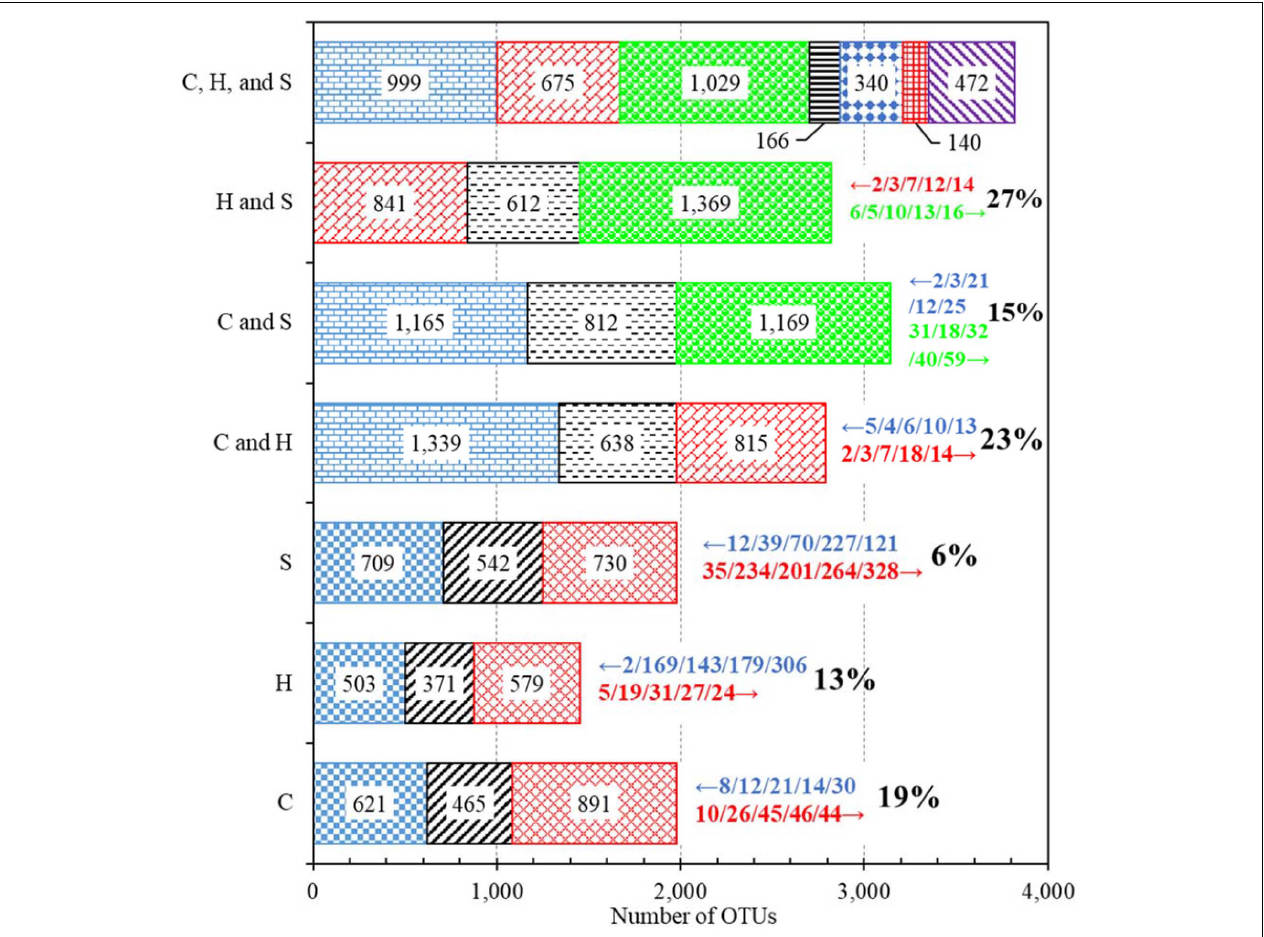
FIGURE 1 | Numbers of OTUs identified from different groups of water samples. C : Cold tap water. H : Hot tap water. S : Shower water. For each of the three horizontal bars of C , H , and S , the left, middle, and right segments represent the numbers of OTUs unique to the first draw, shared by the two draws, and unique to the second draw, respectively. For each of the three bars of C and H , C and S , and H and S , the left, middle, and right segments represent the numbers of OTUs unique to cold (for the bars of C and H and C and S ) or hot (for the bar of H and S ) tap water, shared by the two groups of water samples, and unique to hot tap (for the bar of C and H ) or shower (for the bars of C and S and H and S ) water, respectively. For the bar of C, H, and S , the first, second, third, fourth, fifth, sixth, and seventh (left to right) segments represent the numbers of OTUs unique to cold tap water, unique to hot tap water, unique to shower water, shared by cold and hot tap water (excluding shower water), shared by cold tap and shower water (excluding hot tap water), shared by hot tap and shower water (excluding cold water), and shared by cold tap, hot tap, and shower water, respectively. Numbers within bar segments: Numbers of OTUs. Numbers marked with leftward and rightward arrows immediately next to the bars (on the right): The IDs of the top five most important OTUs (descending order of abundance, left to right) that had significantly greater ( p < 0.05) abundance in the groups represented by the farleft and farright segments, respectively. Percents next to the rightward arrows (on the right): Percents of OTUs (among the shared ones) that had significantly different abundance between the two groups ( p <